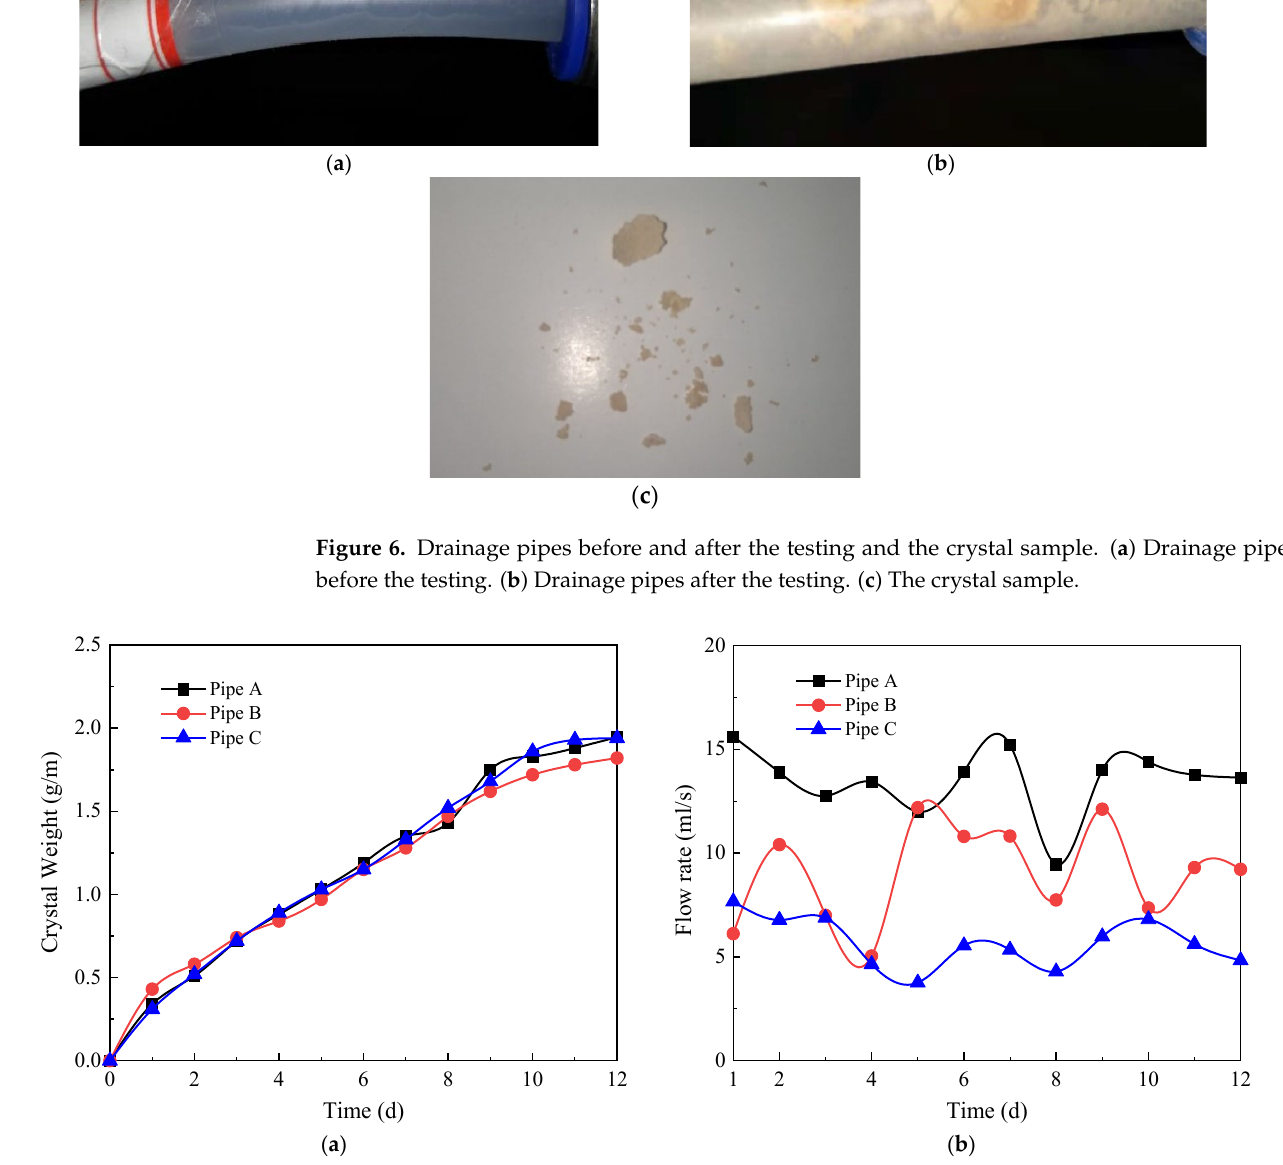
Figure 7. Variation of crystallization rate and flow rate of different circular drainage pipes with time. ( a ) Crystallization rate curves. ( b ) Flow rate curves.